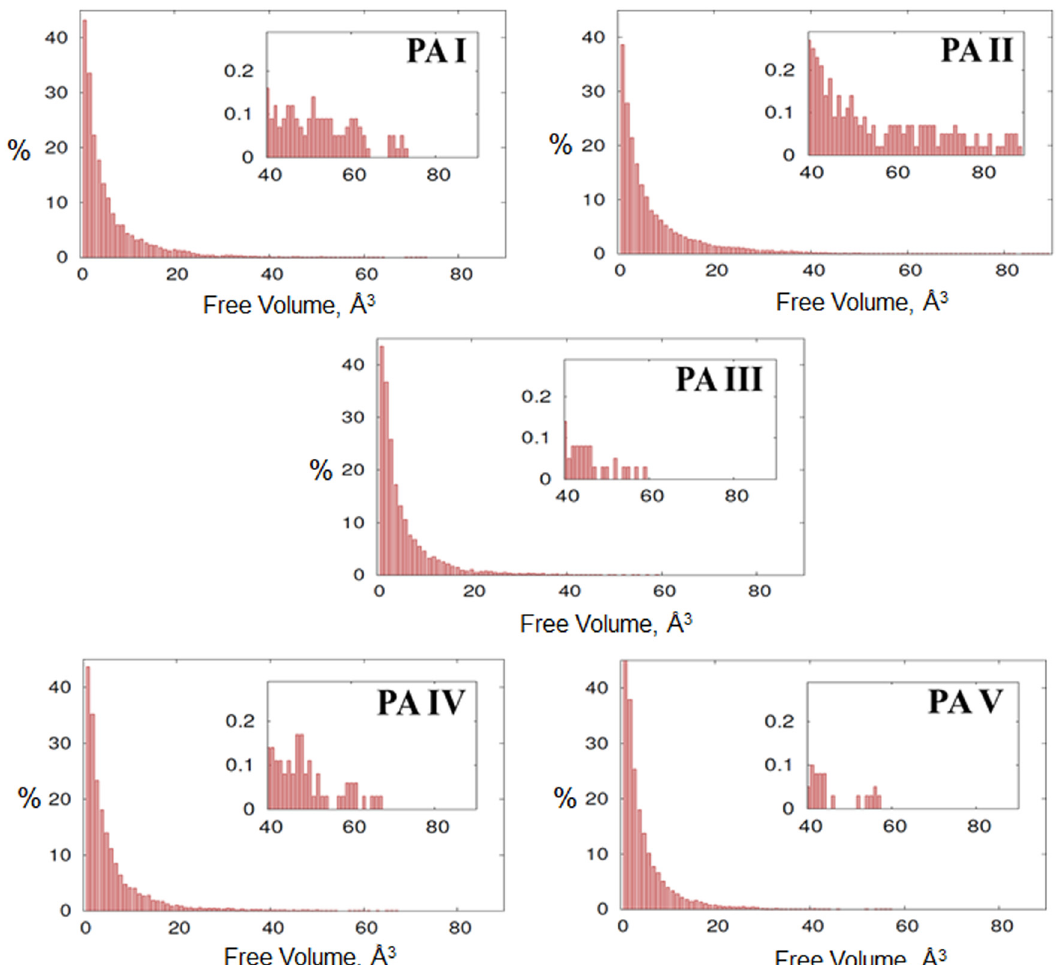
Figure 16: Free volume distributions ( FVDs ) of the PAs ( PA I to PA V = PA K - i to PA K - v in Figure 14 ) ( 93 ) . Copyright 2015, Reproduced with permission from American Chemical